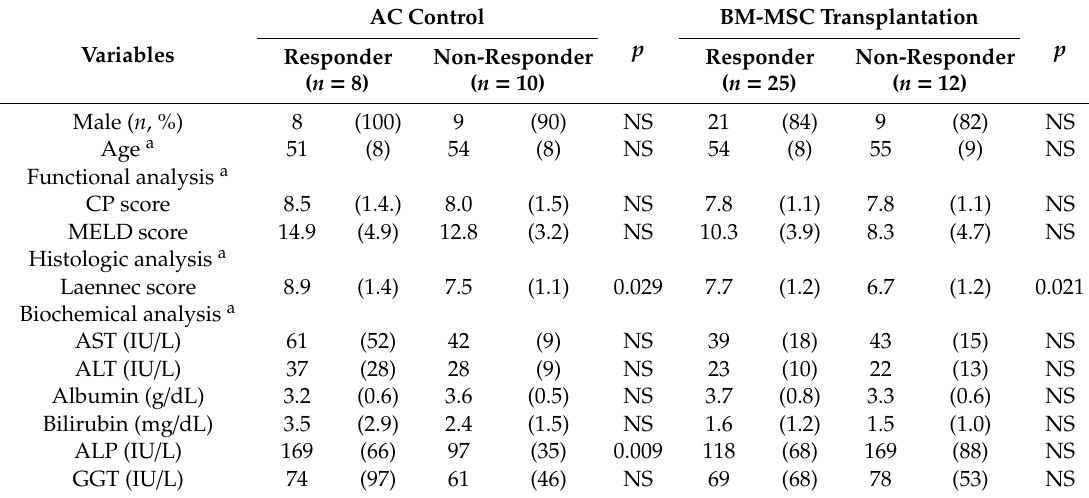
Table 1. Baseline characteristics of